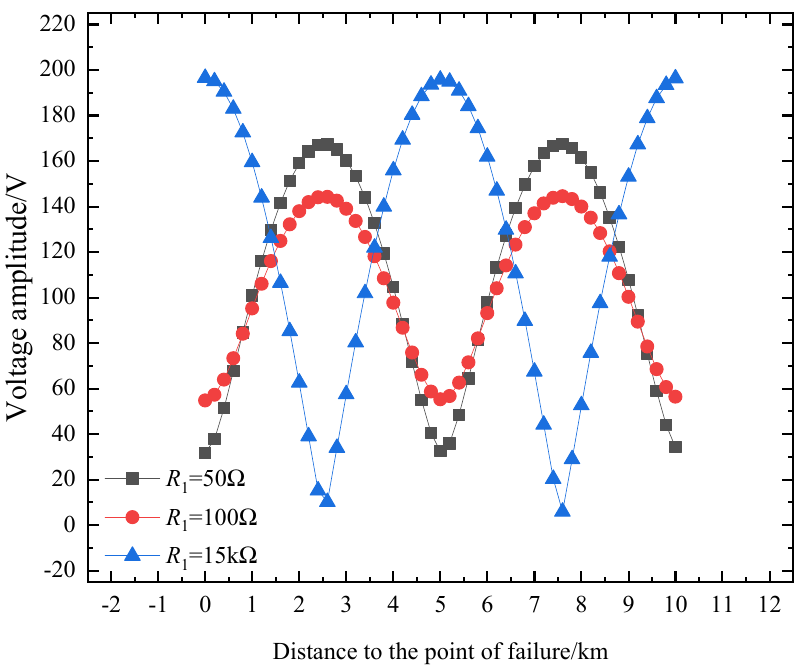
Figure 8. Distribution of traveling standing waves on transmission lines under different grounding resistance faults.